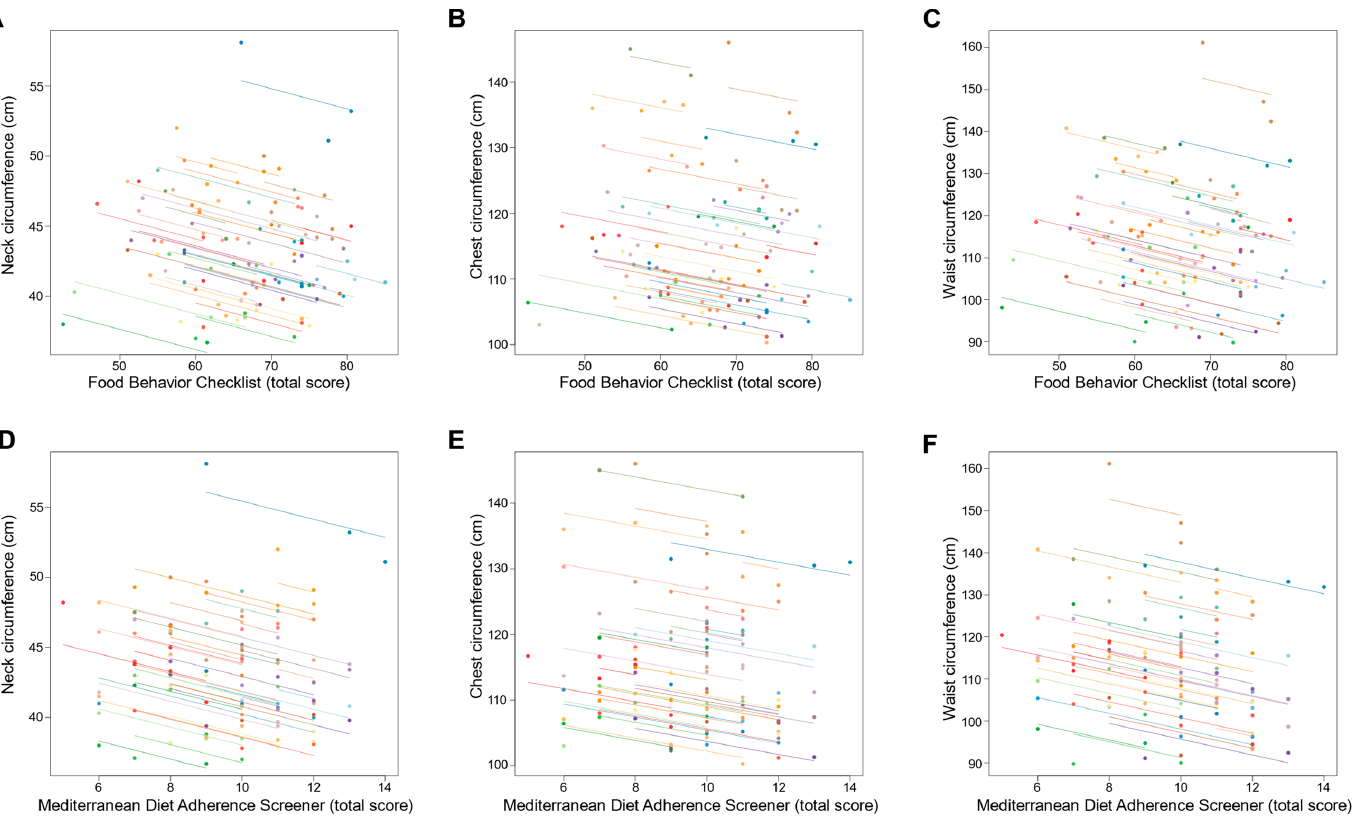
Figure 5. Association of changes in dietary behavior over time with changes in body circumferences outcomes Each dot represents one of three separate observations (baseline, 8 weeks and 6 months after intervention) of dietary behavior—as measured by the Food Behavior Checklist ( A – C ) and Mediterranean Diet Adherence Screener ( D – F )—and body circumferences outcomes for a participant. Observations from the same participant are given the same color, with corresponding lines to show the repeated measures correlation fit for each participant. ( A – C ) The Food Behavior Checklist assesses dietary behavior (range, 23–85; higher scores indicate healthier dietary behavior) [45]. ( D – F ) The Mediterranean Diet Adherence Screener assesses adherence to the Mediterranean diet (range, 0–14; higher scores indicate greater adherence; scores ≥ 10 indicate high adherence to the Mediterranean diet) [46].